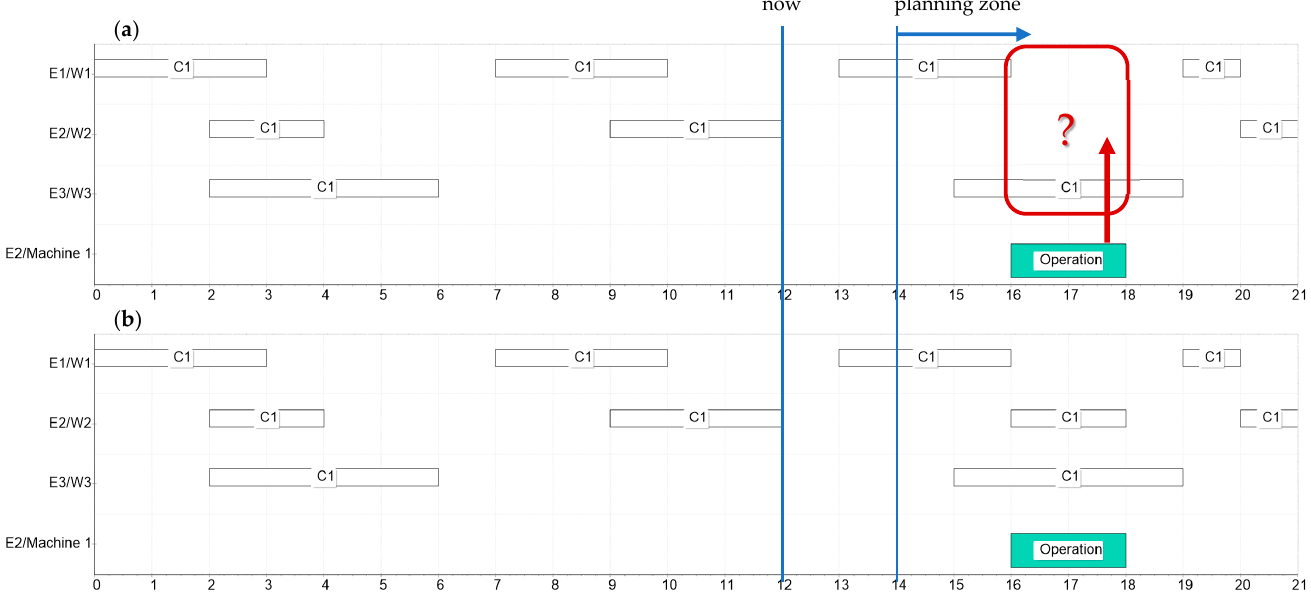
Figure 14. The scheduling of the additional human resource for an operation based on work experience within competence C 1 , ( a ) two resources are available: worker 1 of enterprise 1 and worker 2 of enterprise 2, ( b ) worker 1 is selected to execute the operation according to Formula (2).